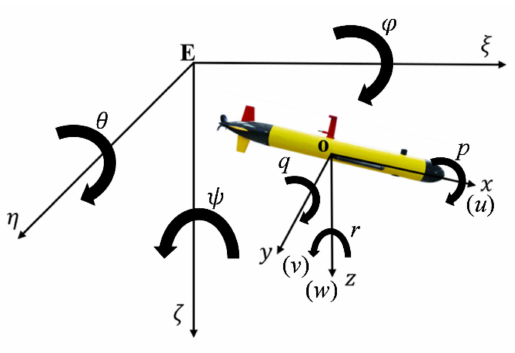
Figure A1. AUV’s hull coordinate system and dynamic coordinate